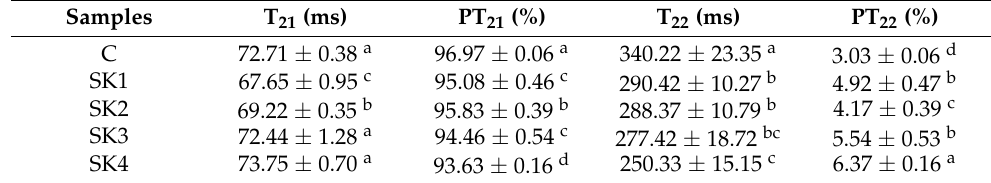
Table 4. Relaxation times and corresponding peak areas of surimi gels with different KEH.